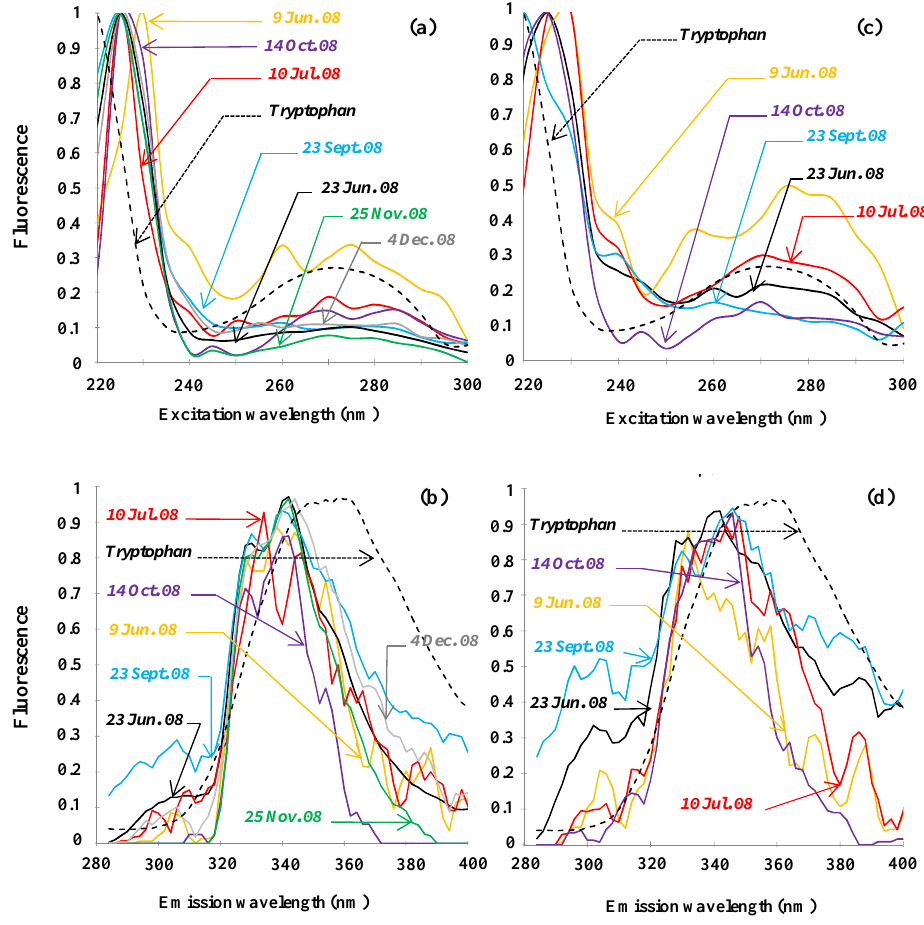
Fig. 7. Normalized excitation and emission spectra of peak T collected on 9 June (orange solid line), 23 June (black solid line), 10 July (red solid line), 23 September (blue solid line), 14 October (purple solid line), 25 November (green solid line) and 4 December 2008 (grey solid line). All these spectra are compared to a standard solution (75µgl − 1 of free dissolved L-tryptophan, > 98%, Sigma-Aldrich, black dashed line). (a) and (c) excitation spectra with Em = 340nm at 2 and 5m depth respectively, normalized to the maximum value intensity in the 220–240nm range. (b) and (d) emission spectra with Ex = 230nm at 2 and 5m depth respectively, normalized to the maximum value intensity in the 320-360nm range. In order to reduce the noise, all these emission-excitation spectra were smoothed by a moving average order 3 which imposes a red shifted of 5 nm.